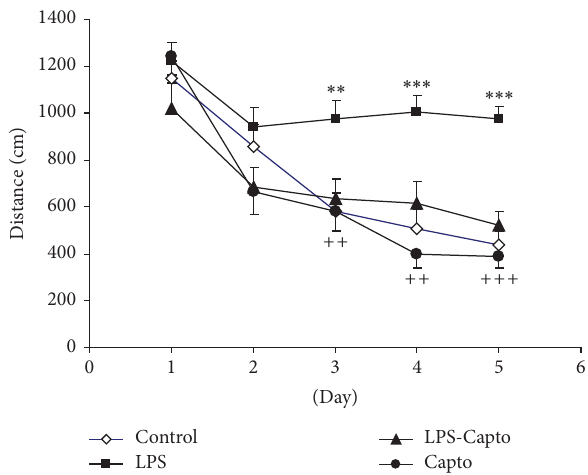
Figure 3: Comparison of the distance traveled to reach the platform in the Morris water maze test between the four groups. Data are presented as mean ± SEM ( 𝑛 = 10 in each group). ∗∗ 𝑃 < 0.01 and ∗∗∗ 𝑃 < 0.001 compared with the control group and ++ 𝑃 < 0.01 and +++ 𝑃 < 0.001 compared with the LPS group.